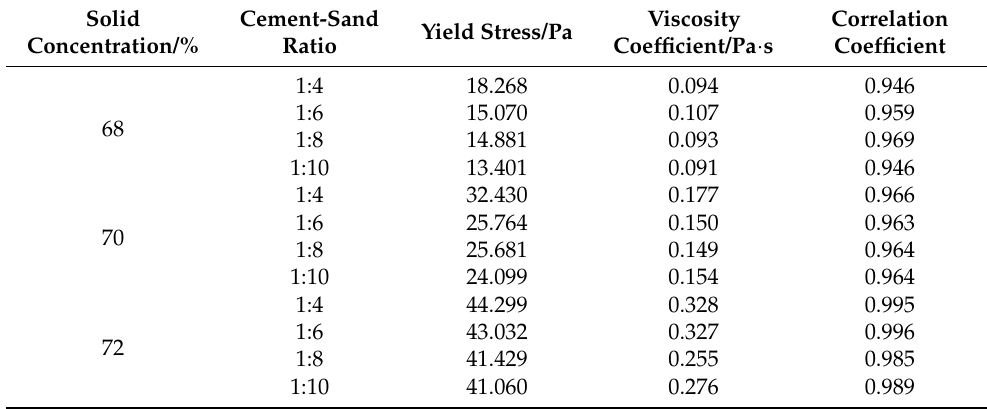
Table 4. Rheological parameters of the slurry prepared with